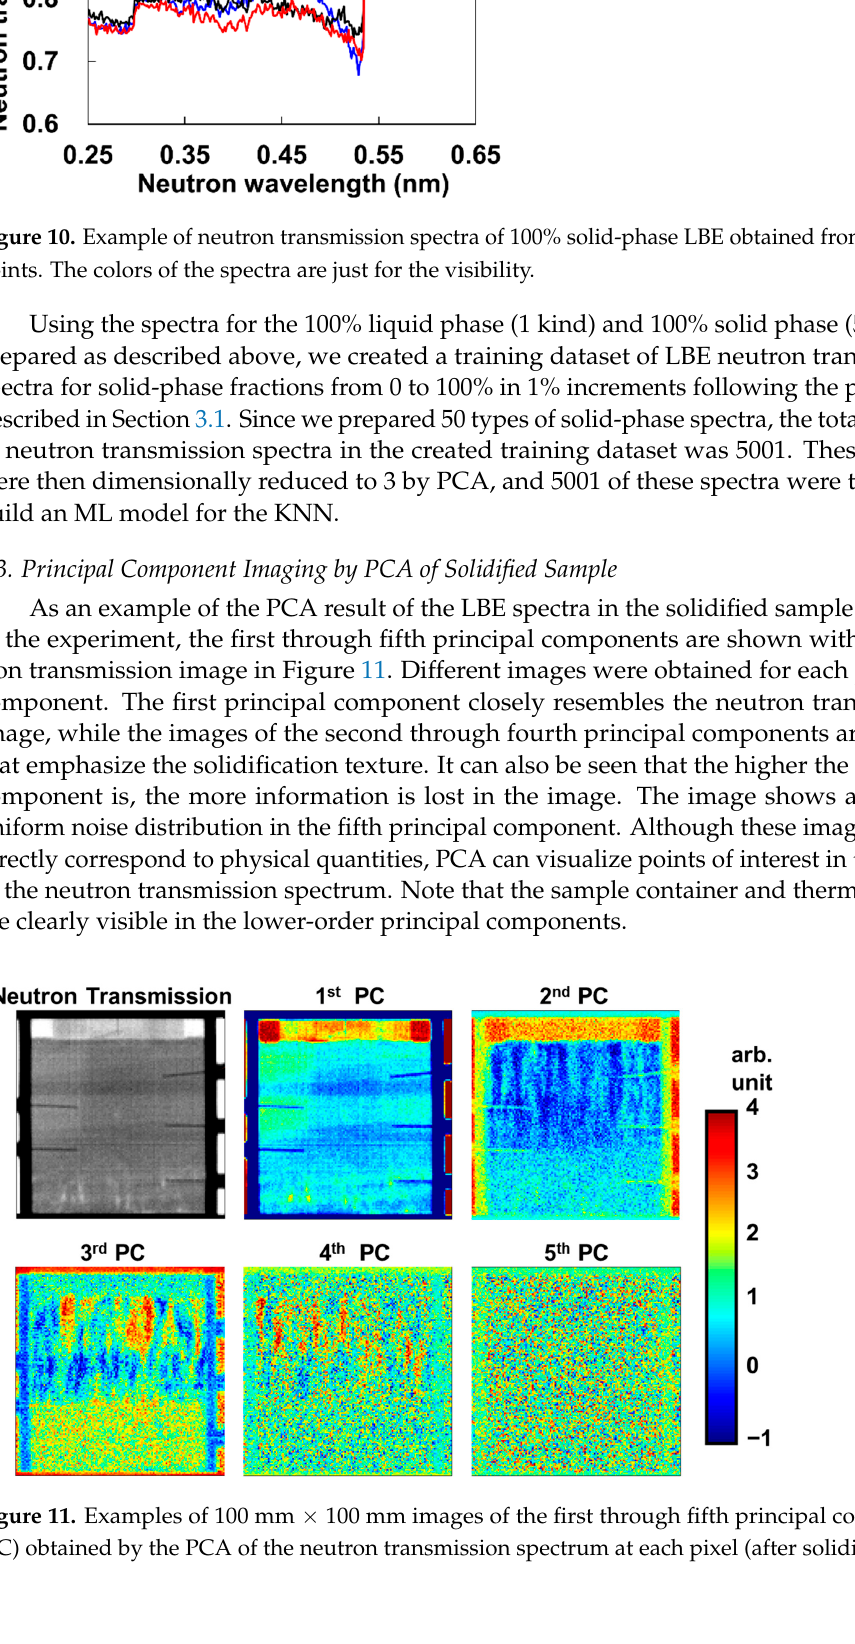
Figure 9. Neutron transmission spectrum of LBE melt obtained by integrating the 100% liquid- phase zone from the TOF imaging experiment.